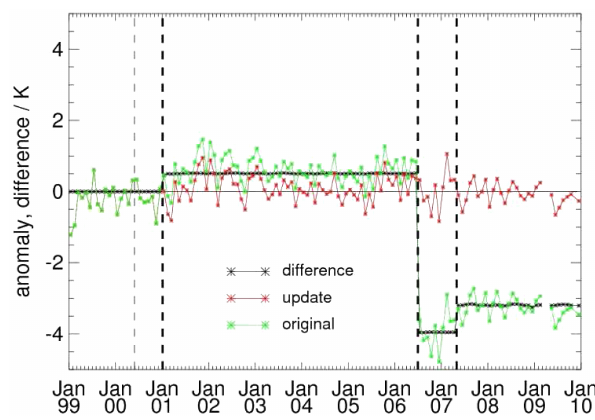
Figure 1. Monthly deseasonalized clear-sky brightness temperature anomaly for the original data (green) and for the updated homo- genized data (red). The black line shows the difference between both anomalies. The thick dashed vertical lines represent the time when homogenization was applied and the thin dashed line repre- sents the time when the blackbody calibration was